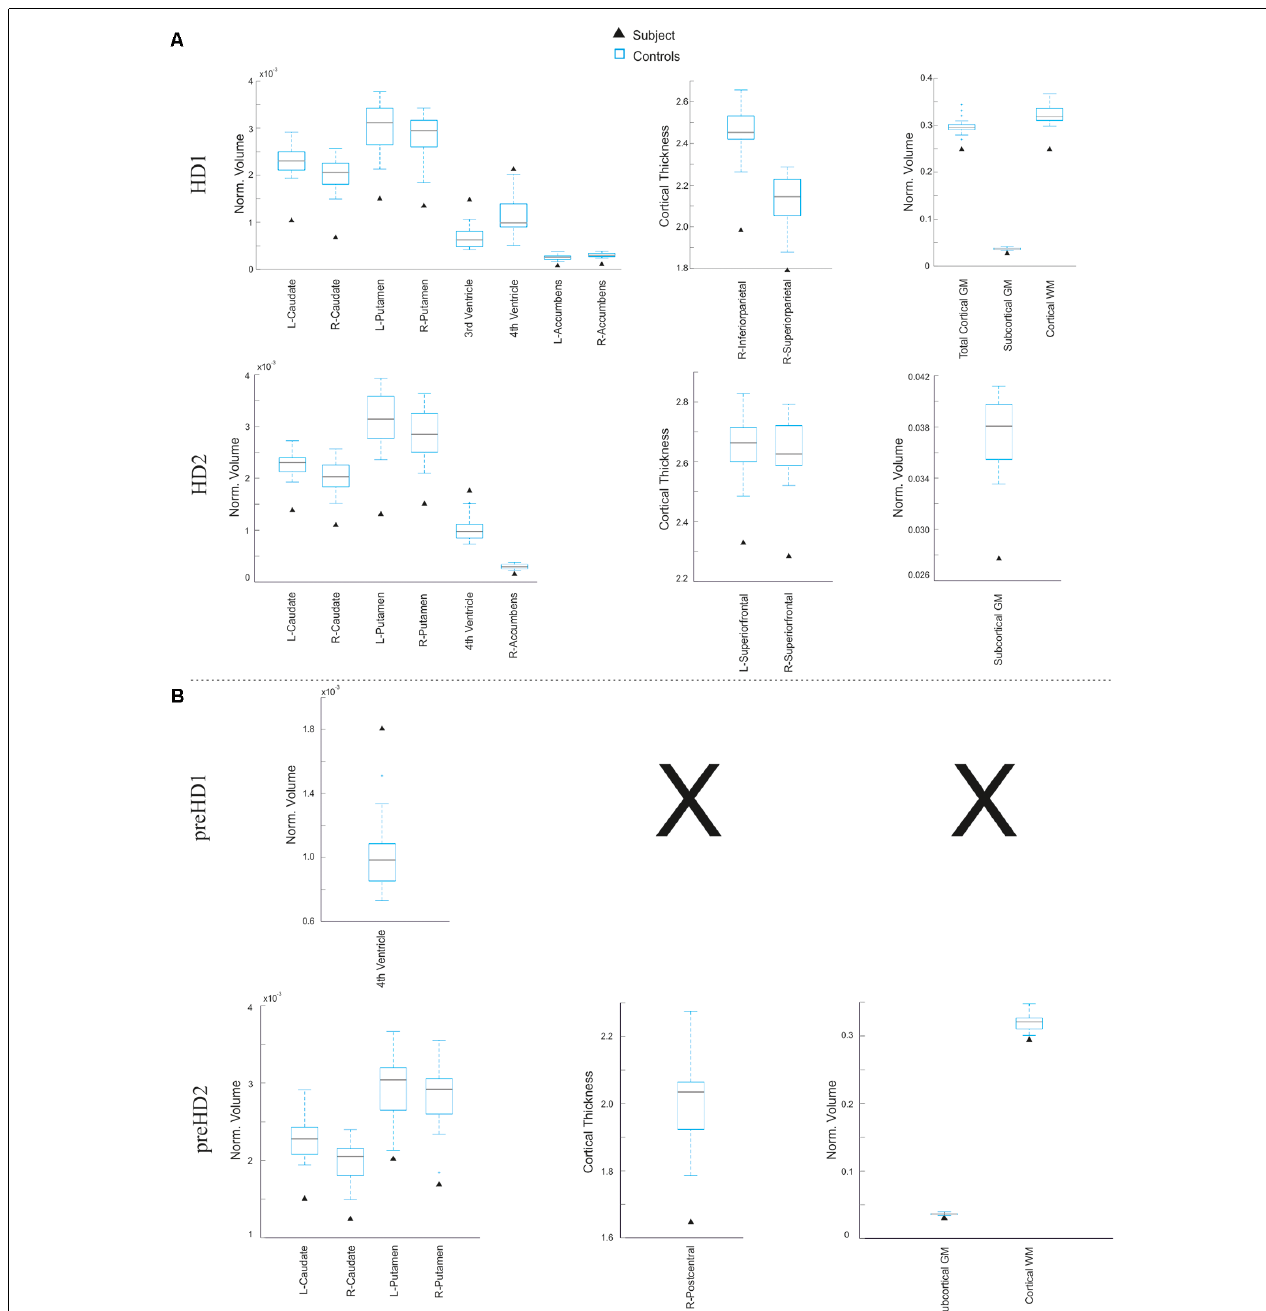
FIGURE 6 | Results derived from the ROI-based analysis. Graphs showing regions in which the subject under study significantly differs from the control group in terms of subcortical volume (left), cortical thickness (center), and global volume of gray matter (GM) and white matter (WM; right) in the manifest (A) and pre-manifest (B)